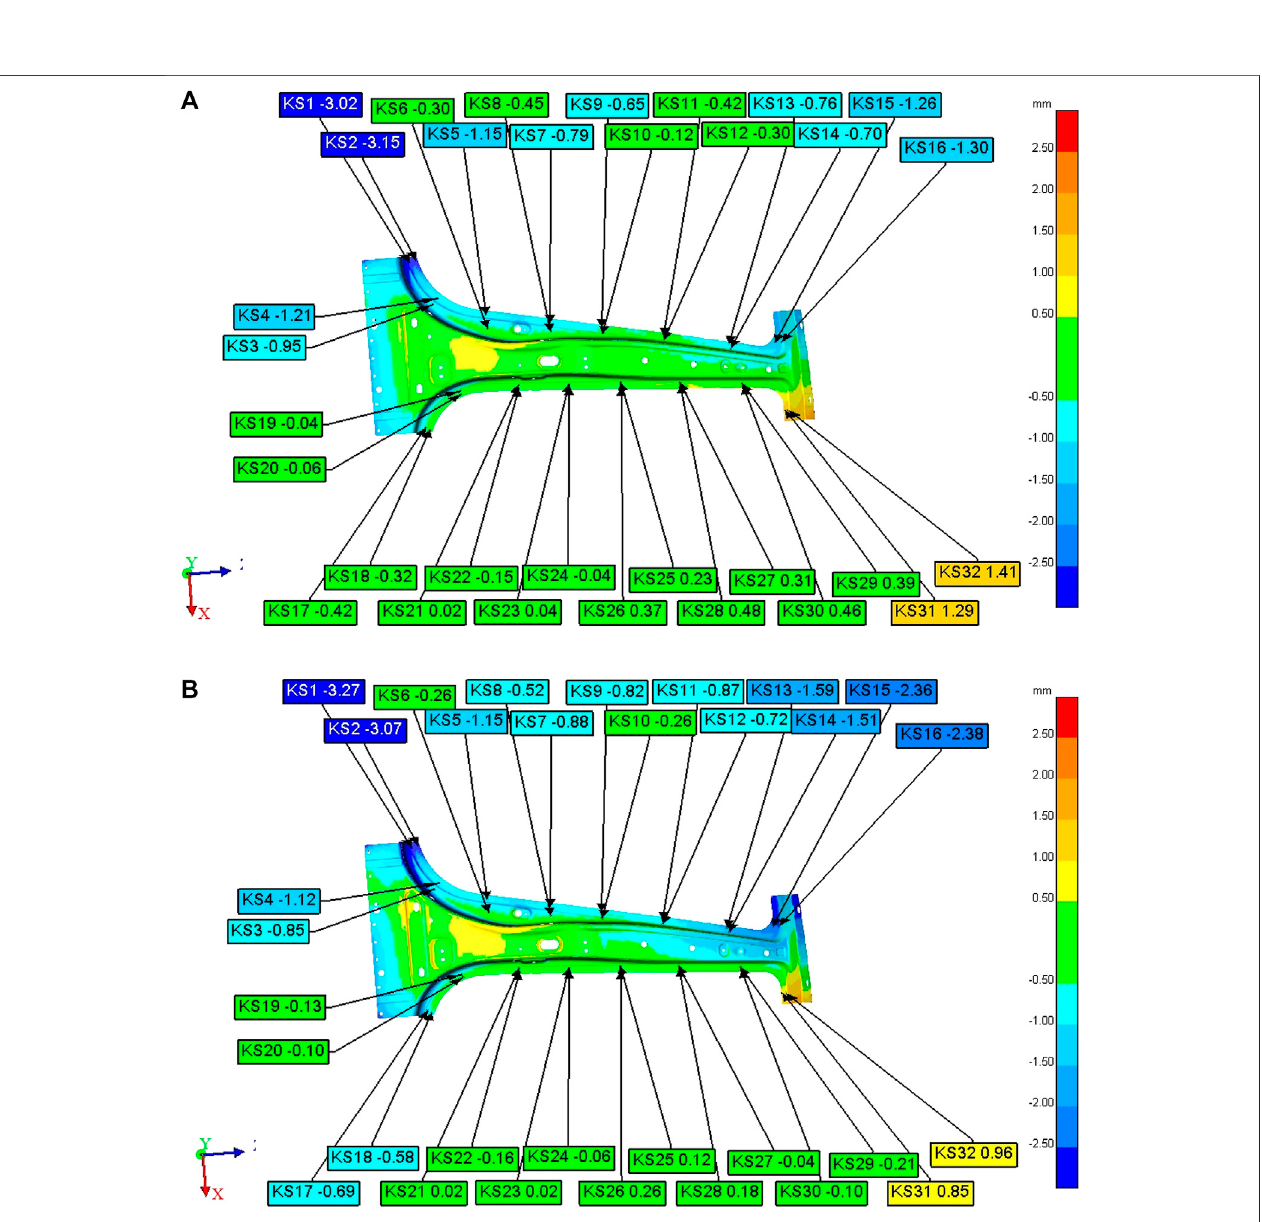
FIGURE 6 | The forming precisions of the part (A) before and (B) after standard aging.